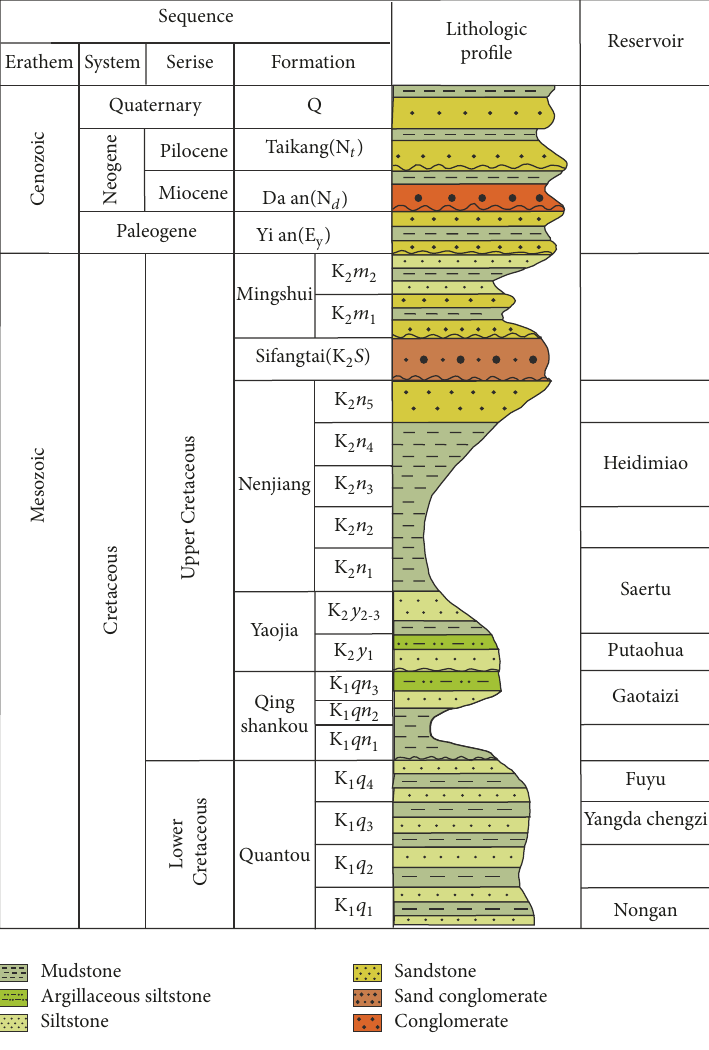
Figure 2: Profile map of the different layers in Beier area.